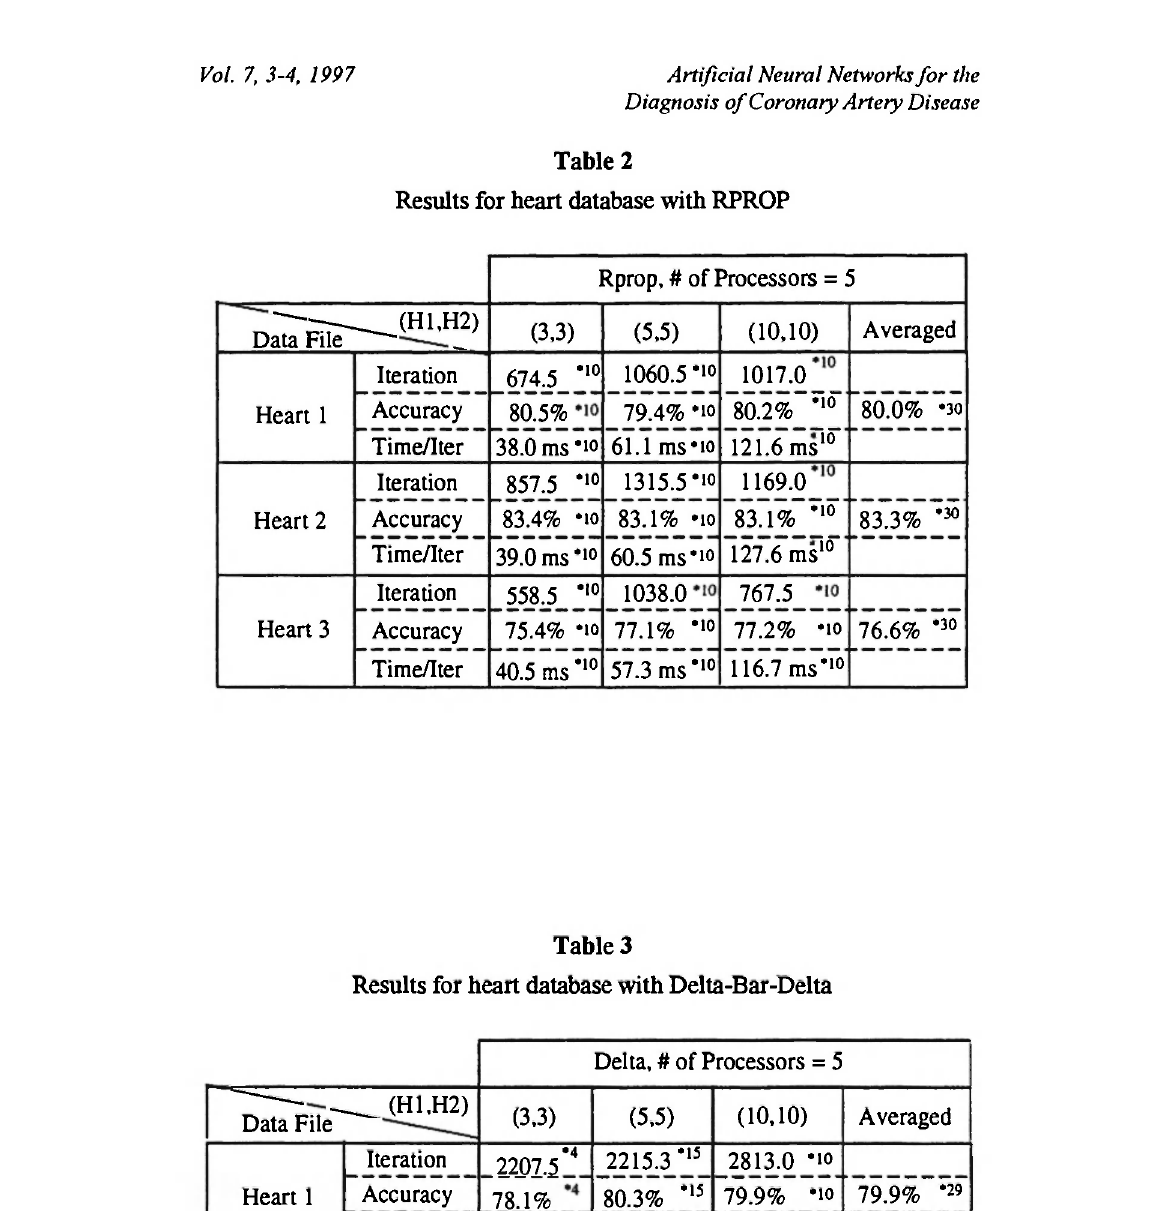
Results for heart database with Delta-Bar-Delta Delta, # of Processors =